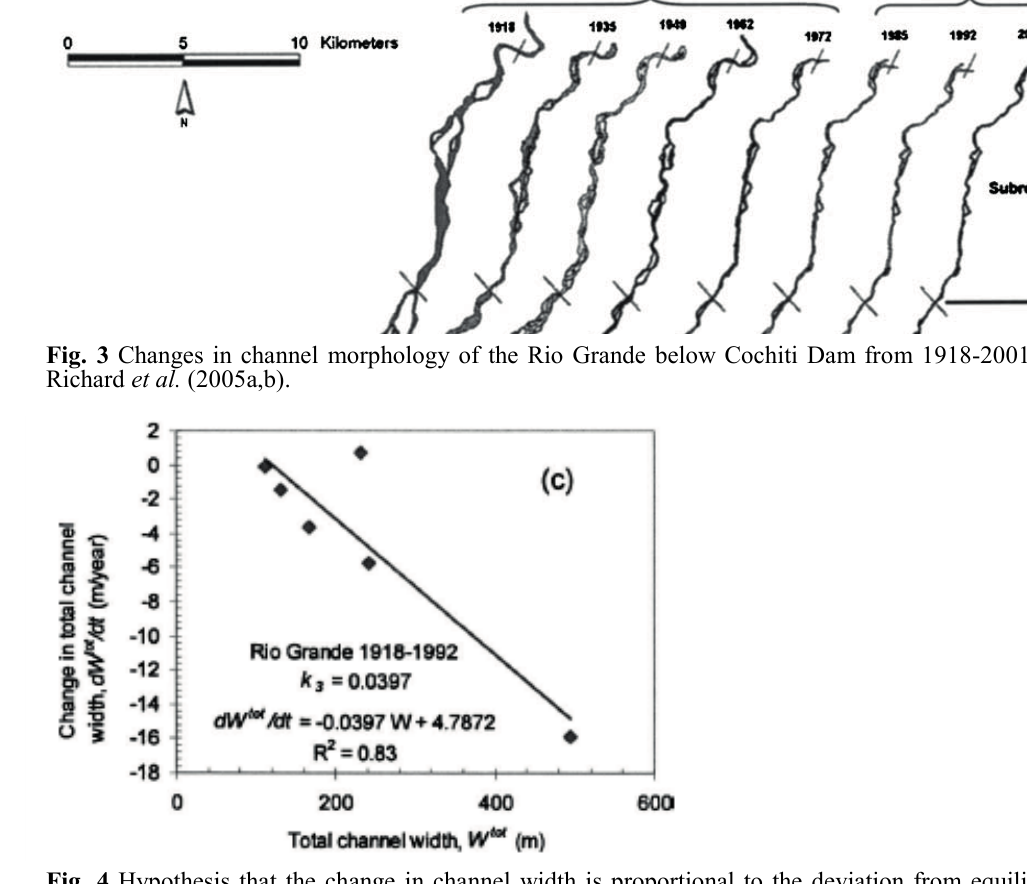
Fig. 4 Hypothesis that the change in channel width is proportional to the deviation from equilibrium from Richard et al .